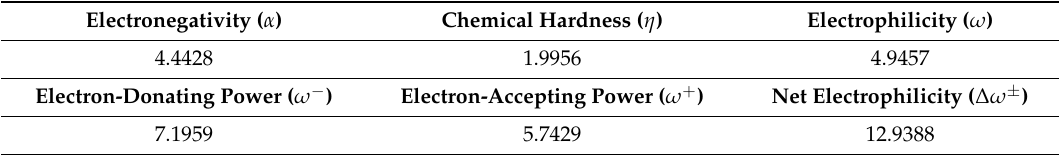
Table 3. Global reactivity descriptors for the Blue-G1 intermediate melanoidin pigment calculated with the MN12SX density